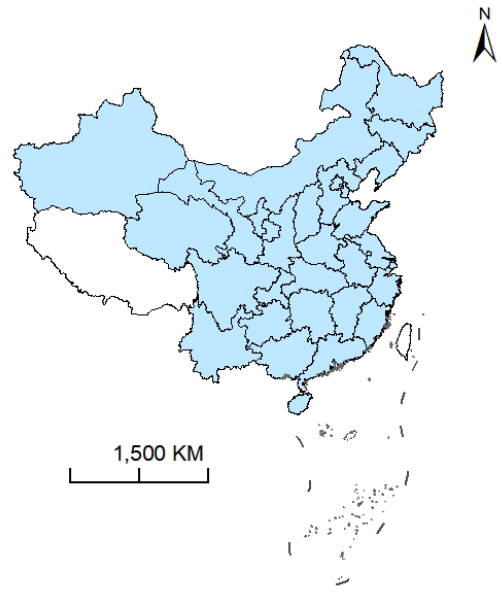
Figure 1. Study Figure 1. Study area.